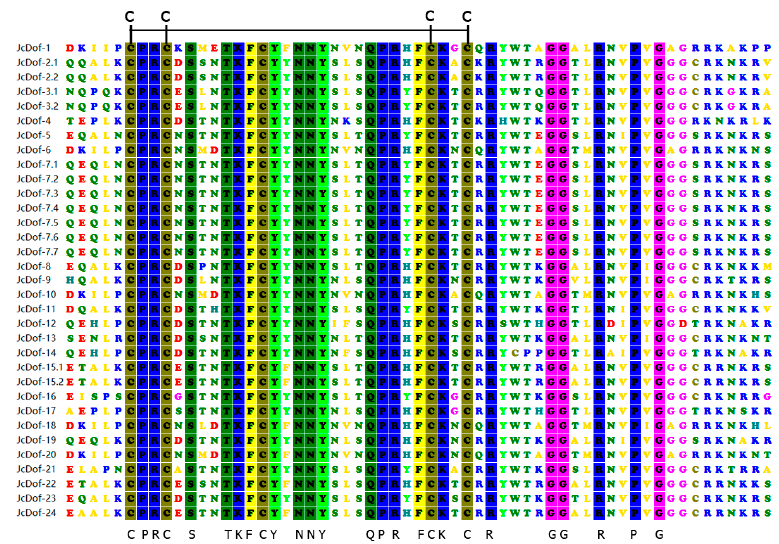
Figure 1. Multiple protein sequences alignments against Dof DNA-binding domain in JcDof genes. The identical amino acids are shown in bottom and the four cysteine residues are indicated on top.